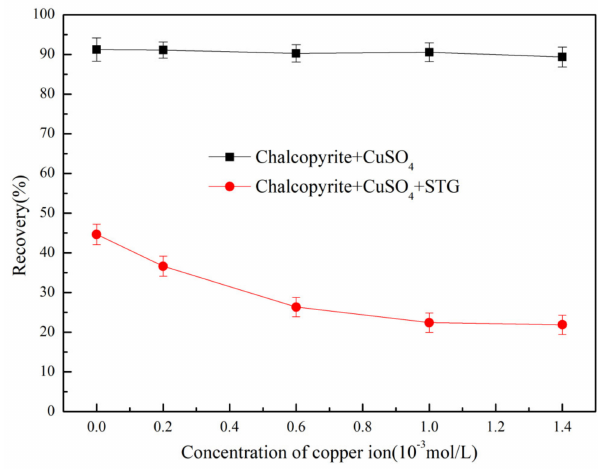
Figure 3. The flotation recovery of chalcopyrite under di ff erent Cu 2 + concentrations; c(STG) = 1.5 × 10 − 3 mol / L, c(BX) = 1 × 10 − 3 mol / L, pH = 10.